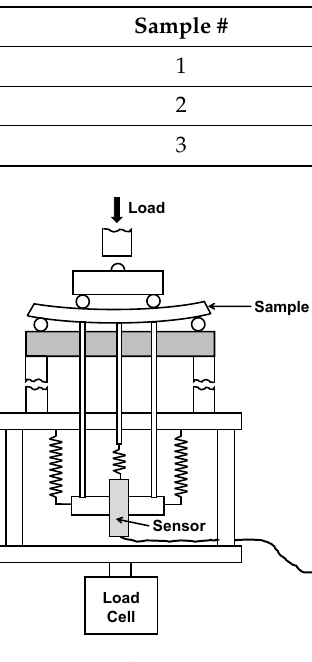
Figure 1. A schematic presentation of a 4-point bending set up. The load is applied by a 2 kN load cell and the deflection is measured by a 3-rod measurement system, where a sensor collects deflection data directly from the sample’s surface under tension.